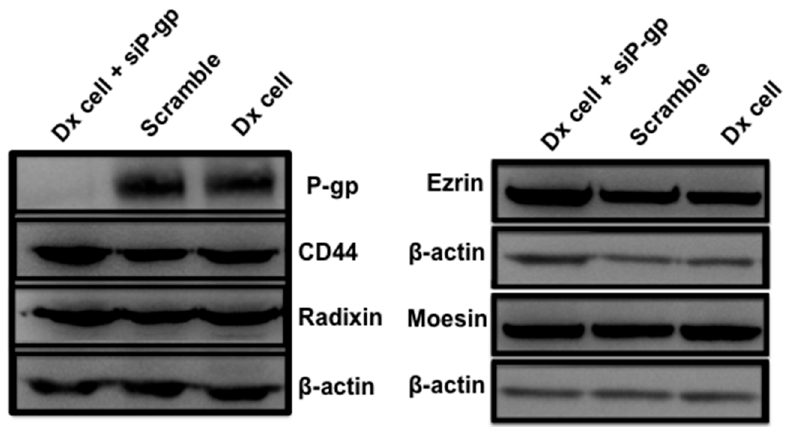
Figure 4. ( A ) Histogram and ( B ) Graph, representing the gene silencing of ERM and CD44—effect on P-gp expression in MCF-7/Dx cells: Dx-cells were silenced with siRNA targeting CD44 (siCD44), Ezrin (siEZR), Radixin (siRDX), Moesin (siMSN) and P-gp (siP-gp) over three days and P-gp expression was evaluated using FCM. Data represents mean ± SD (n = 3).